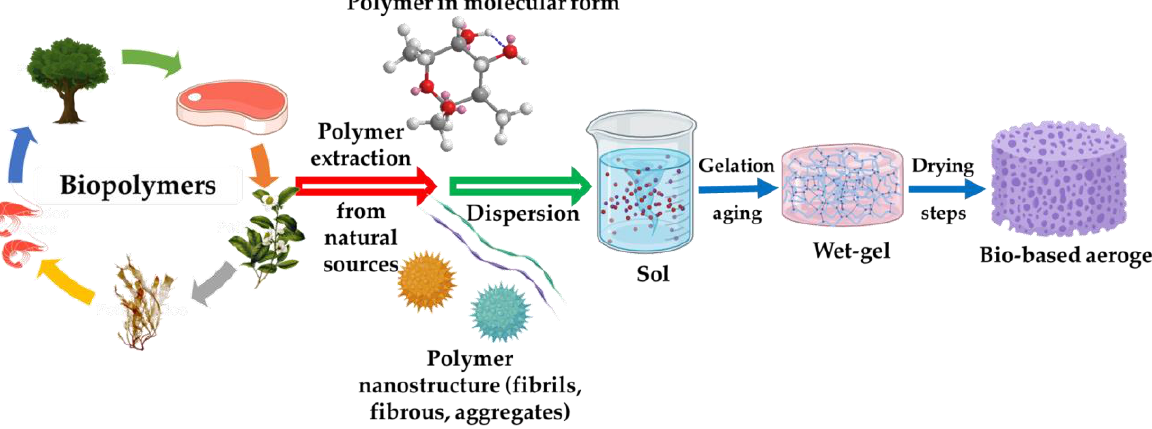
Figure 1. Schematic representation of biopolymeric aerogel elaboration